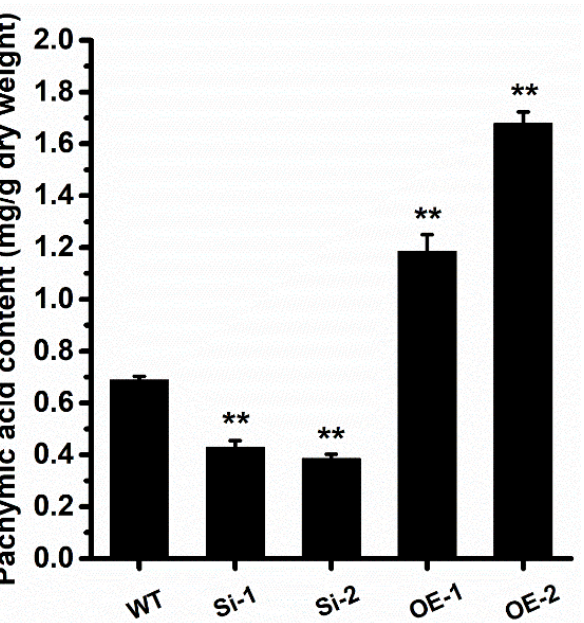
Figure 5. WcSOAT is involved in pachymic acid synthesis. The content of pachymic acid in indicated W. cocos strains was analyzed. Data were obtained from three independent experiments with total 9 replicates. ** indicate statistical differences at p ≤ 0.01 compared with WT strain, one-way ANOVA.